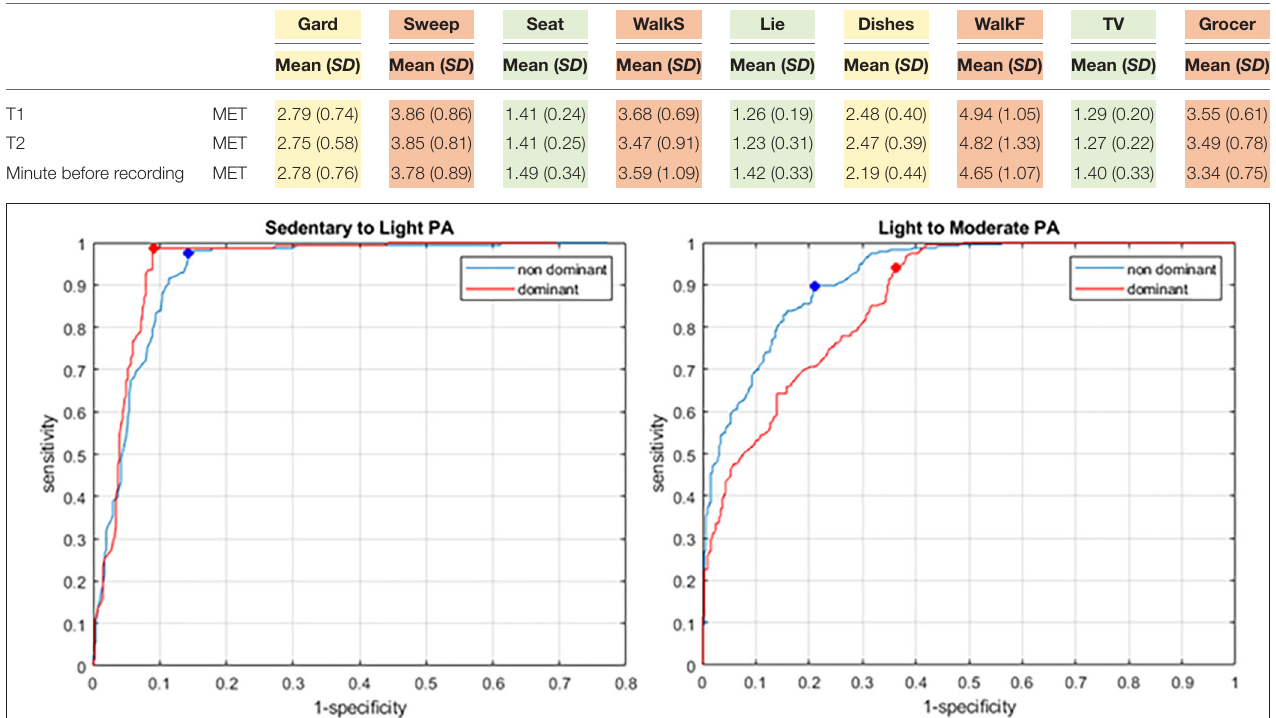
participants had recovered, with MET values of 1.49 ( SD , 0.34), 1.42 ( SD , 0.33), and 1.40 ( SD , 0.33) prior to the three sedentary